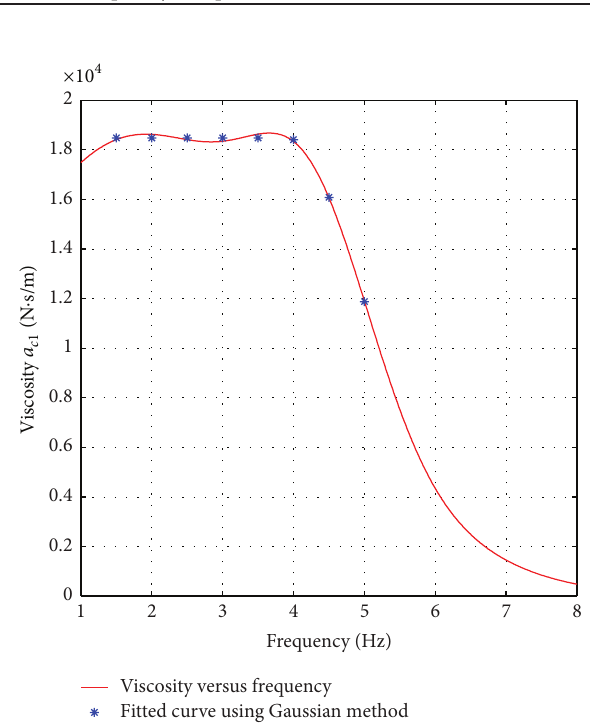
Figure 8: Variation MR damper viscosity 𝑎 𝑐1 versus frequency.